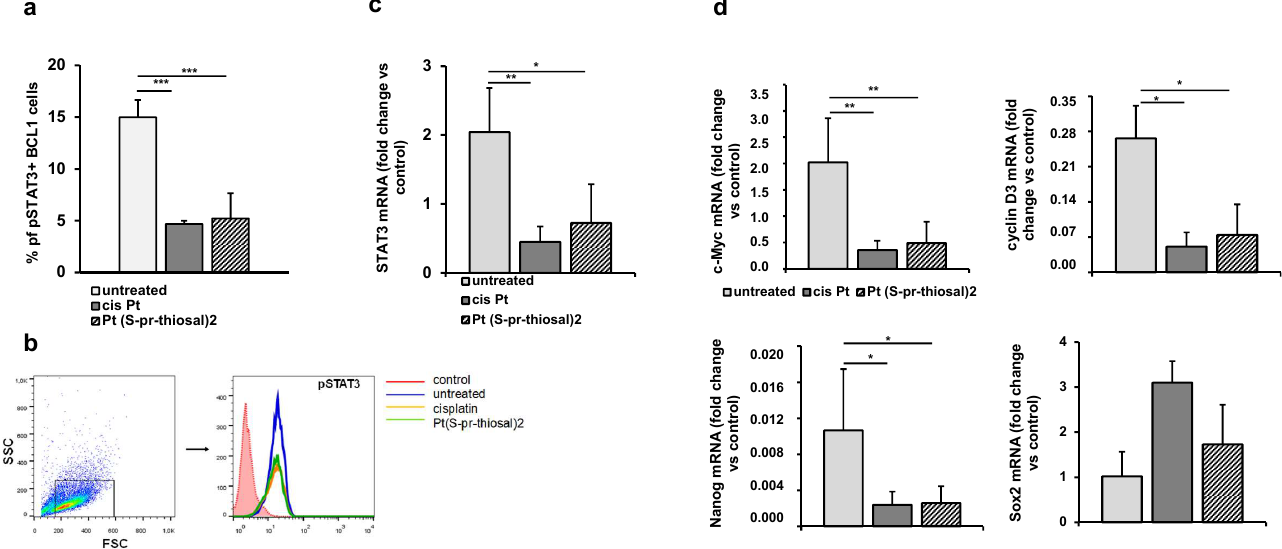
Figure 6. Pt( S -pr-thiosal)2 decreases the expression of phosphorylated STAT3 and STAT3 regulated genes in BCL1 cells. ( a ) The percentage of (phospho Y705) STAT3 positive BCL1 cells was detected by flow cytometry, the relative expression of mRNA for ( c ) STAT3 and ( d ) c-Myc, cyclin D3, Nanog, and Sox2, normalized to β -actin, was analyzed by real-time qRT-PCR and presented as mean values + SD for 5 samples per group. The statistical significance was determined by Student’s t test; * p < 0.05, ** p < 0.01, *** p < 0.001. ( b ) Representative histograms show the expression of phosphorylated STAT3 in untreated, cisplatin-treated, and Pt( S -pr-thiosal)2 treated BCL1